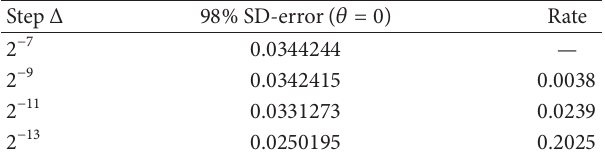
Table 5: The performance of fully explicit SD scheme (101) applied to SDE (2) with parameter set (𝑥 0 ,𝑘 1 , 𝑘 2 ,𝑘 3 ,𝑞,𝑇) = (1/16,1/16, 1, 0.4, 3/4, 1) .